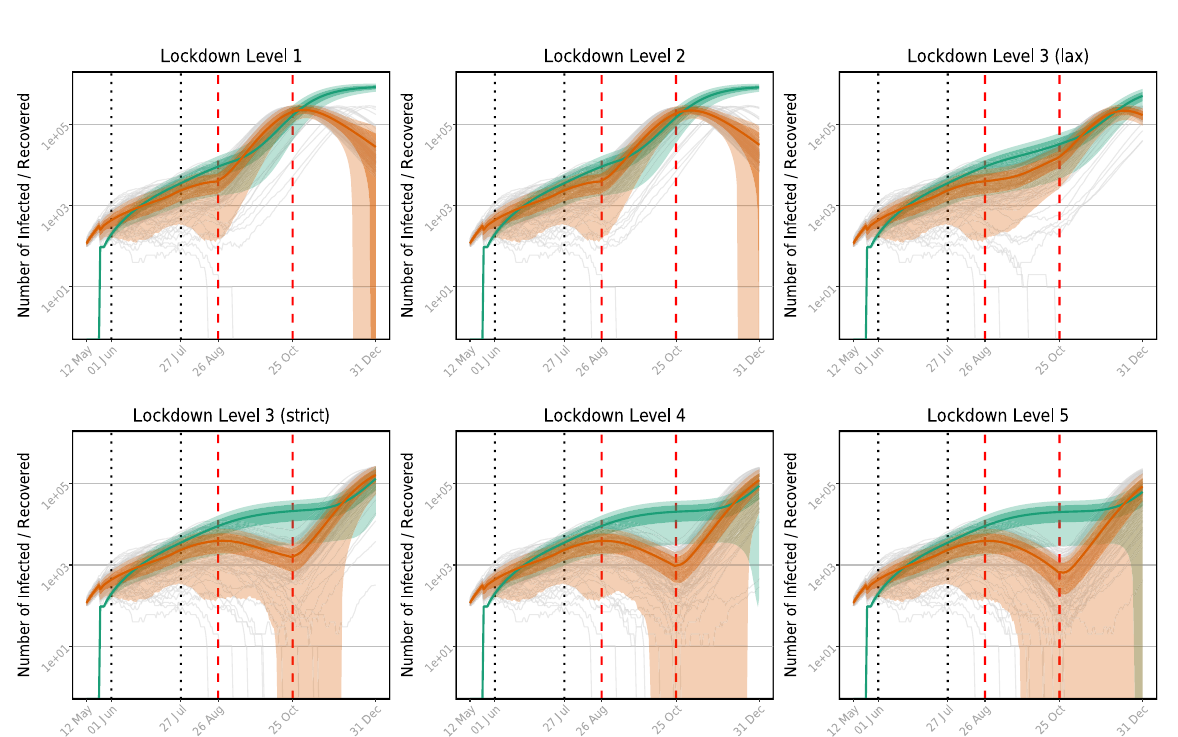
Fig. 8 Simulated infection dynamics in NMBM with an anticipated 60 day lockdown from 26 August 2020 on. All lockdown measures end after 60 days on 25 October 2020. Compared to the lockdown scenarios of 30 days (Fig. 7), the mitigating effect of the measures is much stronger and leads to a temporal trend reversal in the three strict policy scenarios. After the end of measures, the active case numbers return to steep exponential growth